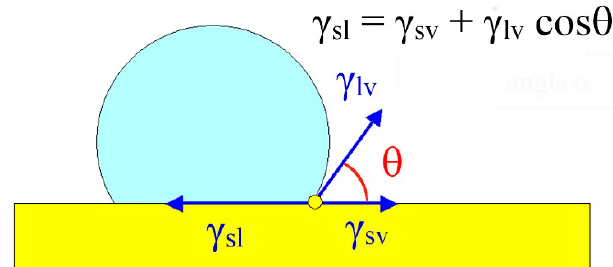
Figure 2. The relationship between the three interfacial tension acting on the boundaries between drop, surface and air (Young’s formula).